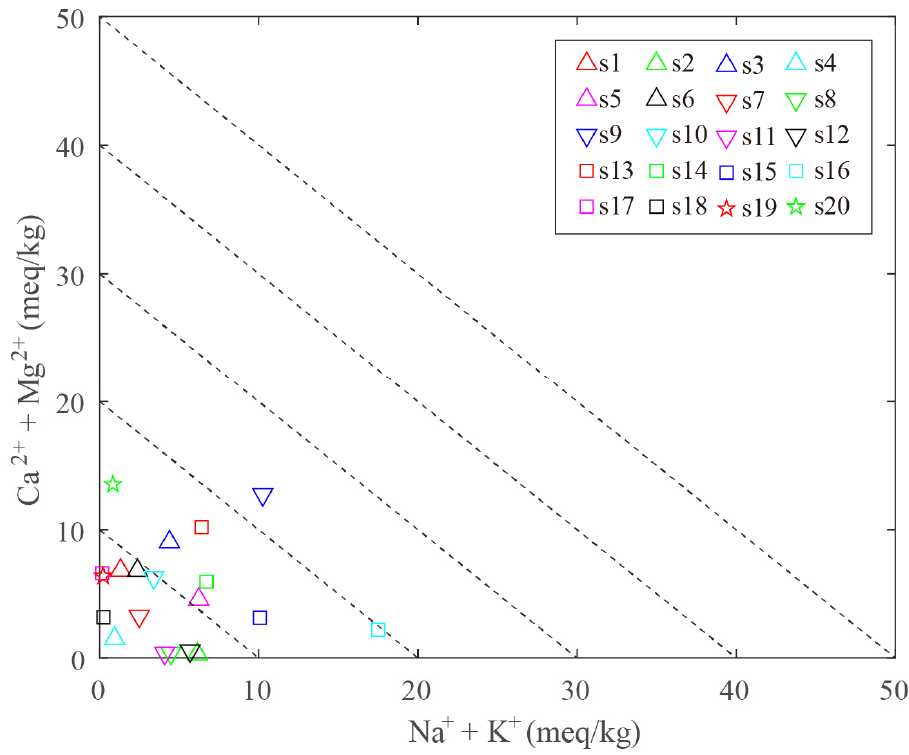
Figure 6. Correlation plot of Na + + K + vs. Ca 2+ + Mg 2+ for the spring water samples in the intersection area of the RRF and the XJF, showing iso-ionic-salinity (TIS) lines for reference.